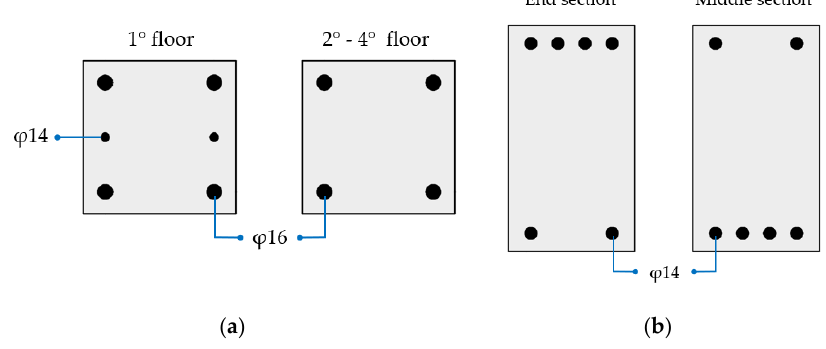
Figure 9. Reinforcement of ( a ) columns and ( b ) beams.